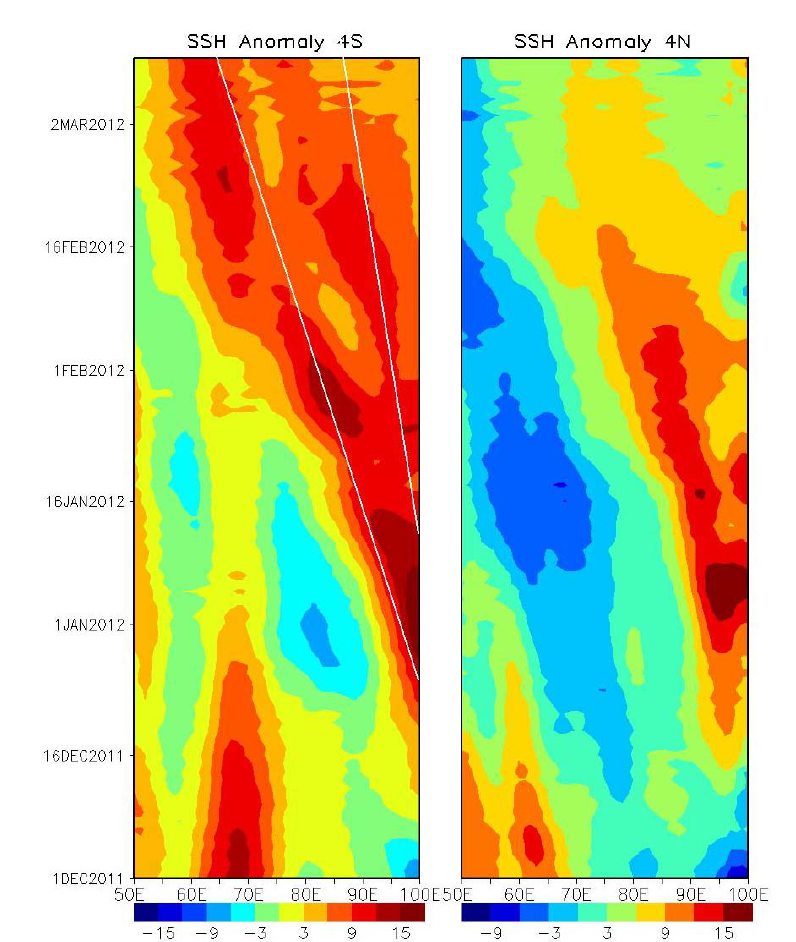
Figure 9. Longitude-time diagram of SSH anomaly (cm) at 4°S ( left ) and 4°N ( right ). The white lines indicate the phase speed of − 0.66 m/s and − 0.33